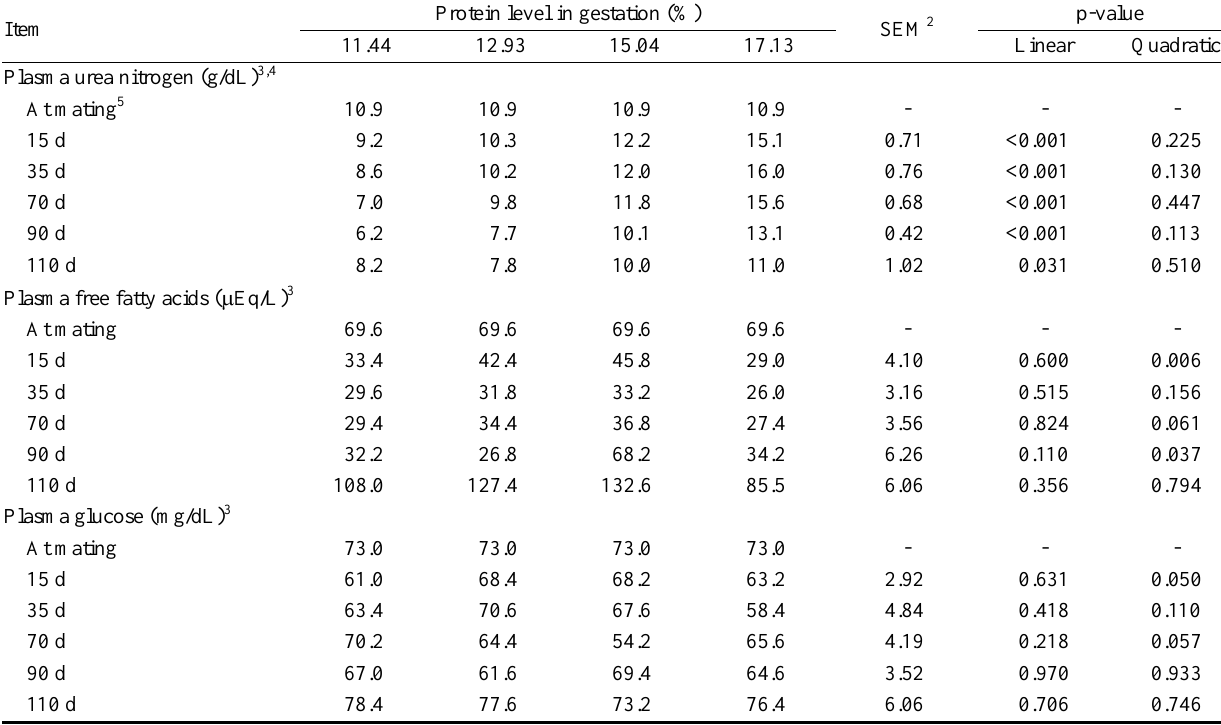
dietary CP level increased. Histidine (p<0.05) content decreased as dietary CP level increased up to 15%, then Table 4. Effect of CP levels in gestation diets on blood profiles of gilts in gestation 1